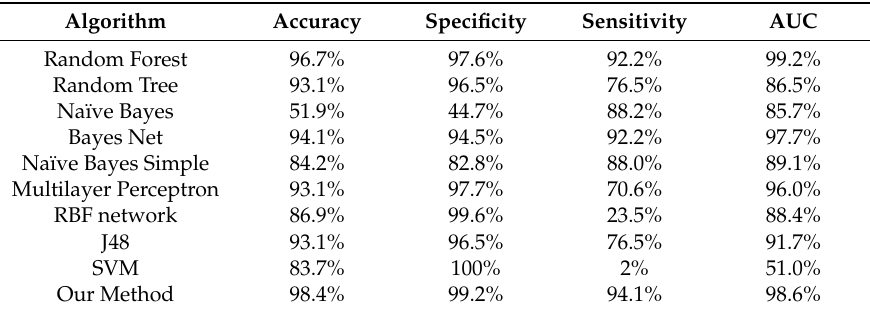
Table 2. Performance comparison of different algorithms on RS features.